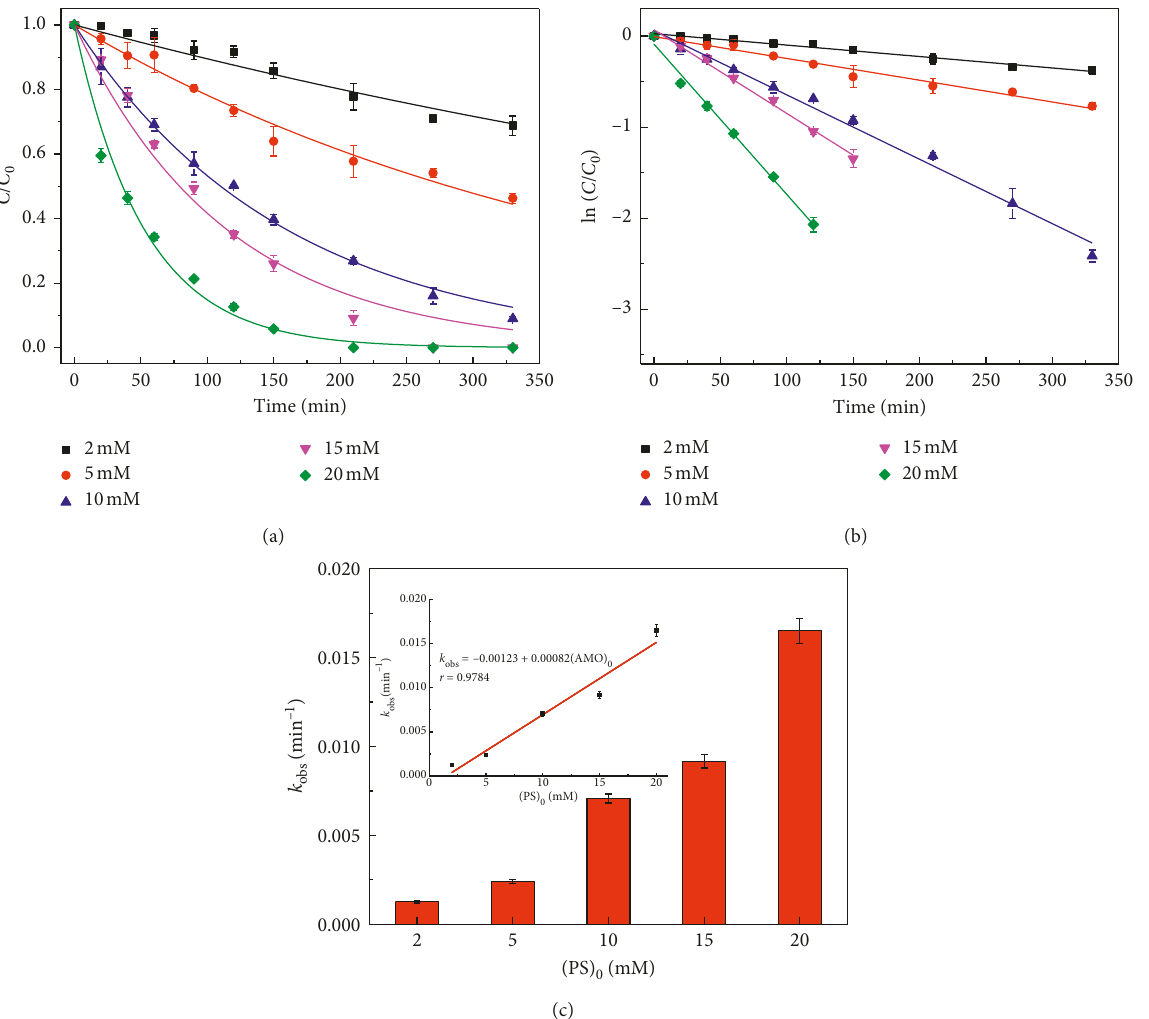
Figure 2: Effects of [PS] 0 on AMO degradation by TAP (a). Plot of ln( C / C 0 ) versus reaction time t for k obs determination with the pseudo- first-order kinetic model (b). Plot of k obs versus [PS] 0 (c). Experimental conditions: [AMO] 0 � 0.1mM; [PS] 0 � 2–20 mM; T � 50 ° C; reaction time �